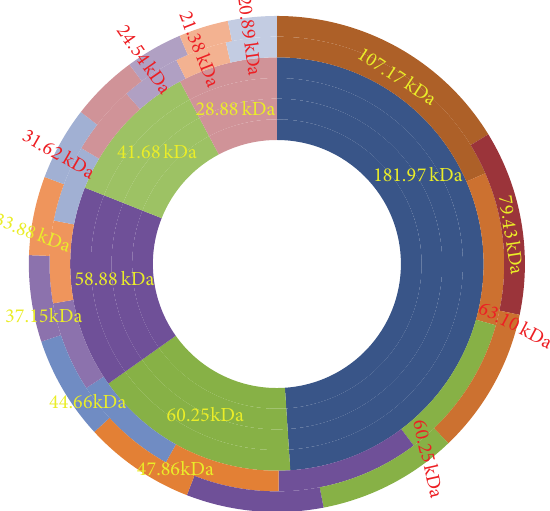
Figure 6: Immunoblot analysis depicted centripetally from M. agalactiae (RPNS 216) WCA; M. agalactiae (RPNS 216) SSA; M. agalactiae (RPNS210)WCA; M.agalactiae (RPNS210)SSA; M.bovis (NC 317) WCA; M. bovis (NC 317)